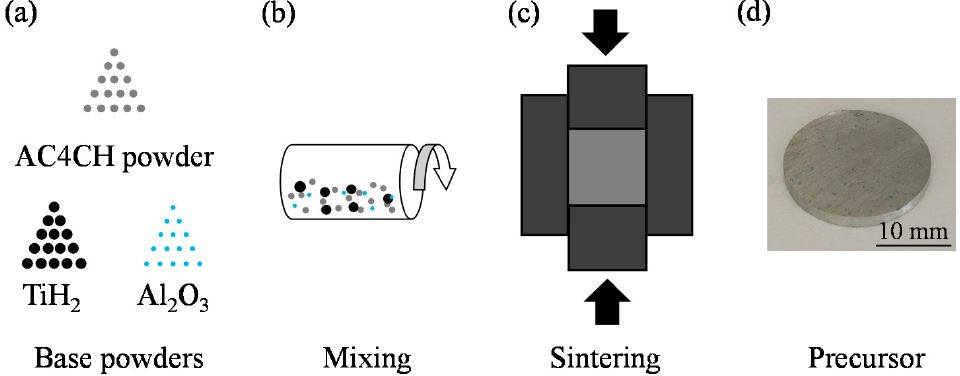
Figure 1. Schematic illustration of preparing AC4CH precursor. ( a ) Base powders used in this study, ( b ) mixing the powders, ( c ) sintering by spark plasma sintering (SPS), and ( d ) photograph of obtained